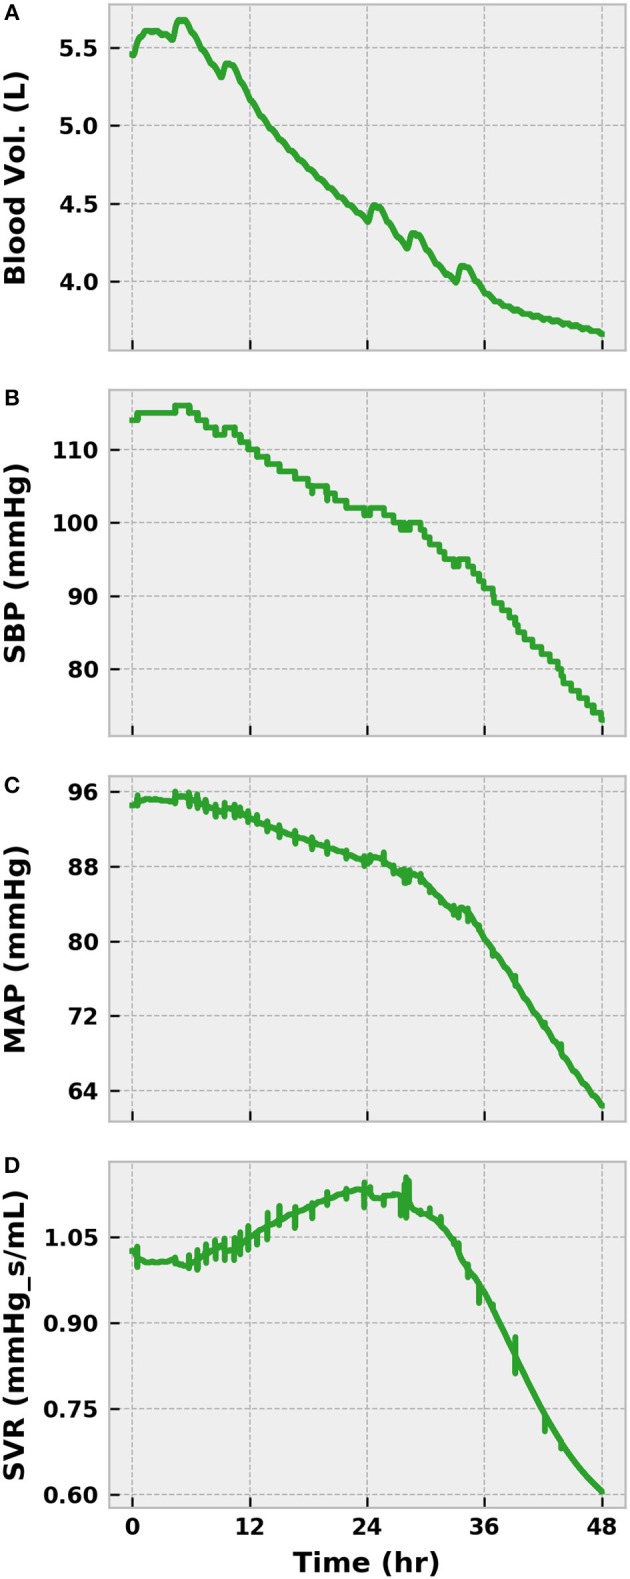
The progression of a severe infection to sepsis and septic shock in the BioGears Engine (Part 1). The accumulation of tissue damage leads to increased fluid conductance between the vascular and tissue spaces, causing a reduction in blood volume (A). Feedback from the baroreceptors prevents significant loss of SBP (B) and MAP (C), for a time by increasing SVR (D) and HR (Figure 5). However, sympathetic inhibition becomes noticeable after 24 h and causes SVR to decrease substantially, resulting in sharp declines in blood pressure. HR continues to increase in an effort to maintain cardiac output (CO). Using SBP < 100 mmHg and tachypnea (Figure 5) as indicators of sepsis, the virtual patient becomes septic at ~30 h.